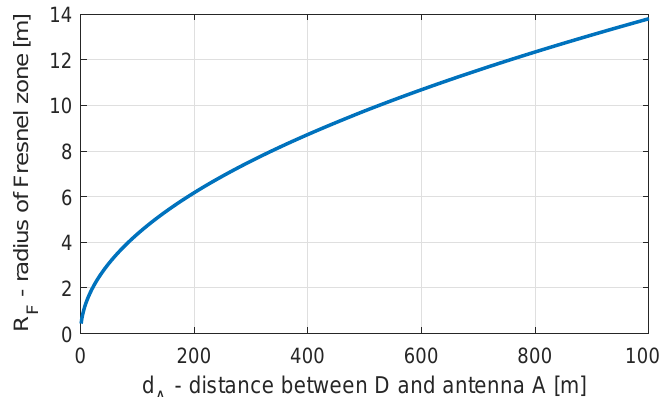
Figure 9. Radius of Fresnel zone for line-of-sight (LOS)